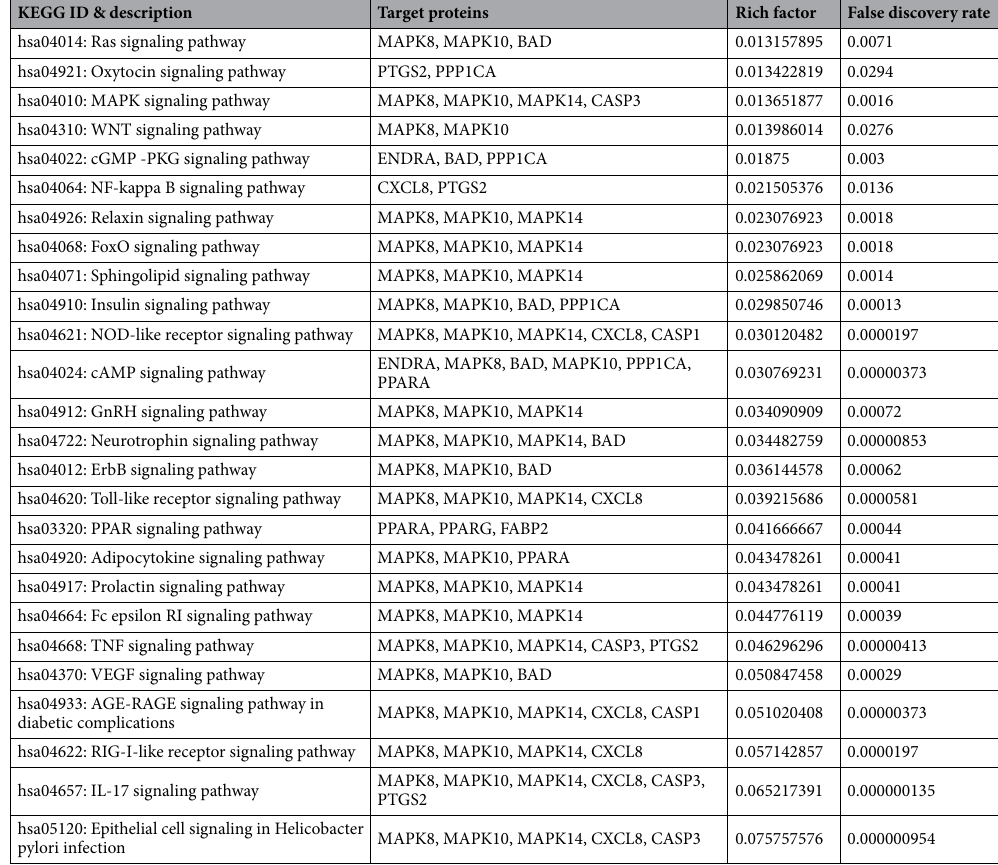
Table 2. Target proteins in 26 signaling pathways enrichment related to COVID-19.